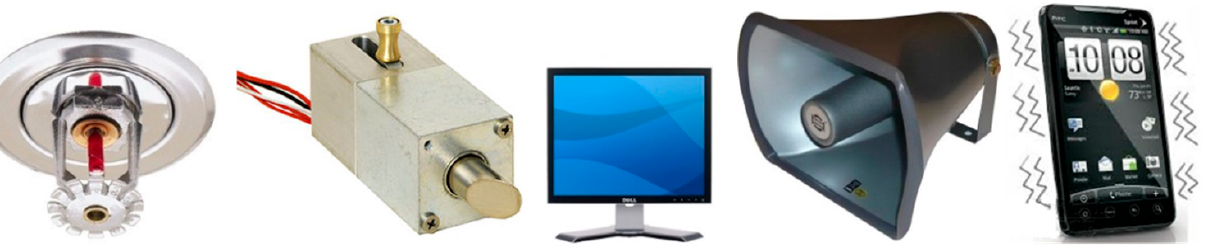
Figure 3. Examples of